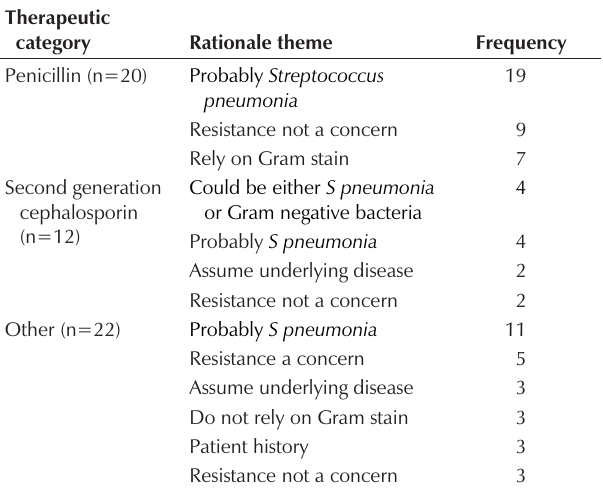
Three most commonly occurring rationale themes in case 2 (open-ended questionnaires) by therapeutic